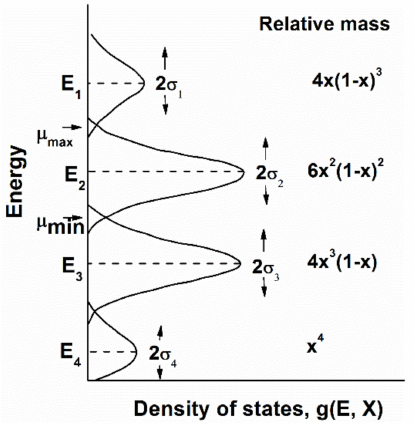
Figure 43. Distribution of bond energies in Ni 1-x Zr x amorphous systems versus the number of H atoms belonging to a given energy level. Adopted from [139], with permission from American Physical Society,